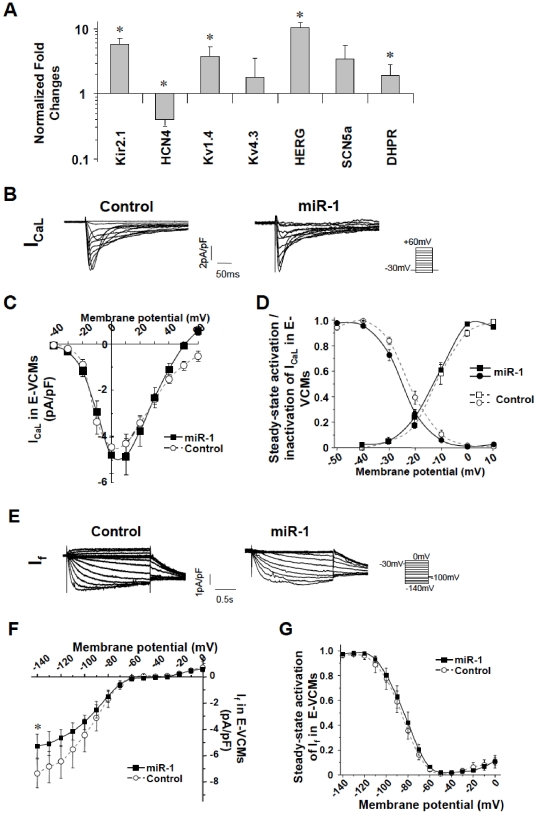
Effects of miR-1 transduction on electrophysiological and molecular properties of hESC-derived CMs.A) Transcriptional expression of sarcolemmal ion channels (Kir2.1, HCN4, Kv1.4, Kv4.3, HERG, SCN5A, DHPR) in hESC-CMs after LV-miR-1 transduction. B) Representative tracings of ICa,L of control and LV-miR-1-transduced hE-VCMs as labeled. Currents were elicited by the electrophysiological protocol given in the inset. Currents shown were nifedipine-sensitive. C–D) The corresponding current-voltage (I–V) relationship, steady-state activation (circle) and inactivation curves (square) of ICa,L. E) Representative tracings of If recorded from control and LV-miR-1-transduced hE-VCMs. Currents were elicited by the electrophysiological protocol given in the inset. Currents shown were ZD7288-sensitive. F–G) The corresponding current-voltage (I–V) relationship and steady-state activation curve of If. * p<0.05.